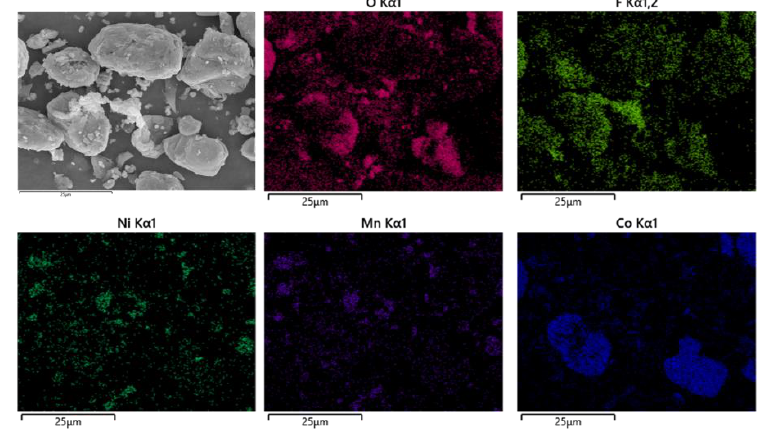
Figure 10. Scanning electron microscopy of nonpyrolyzed battery materials.